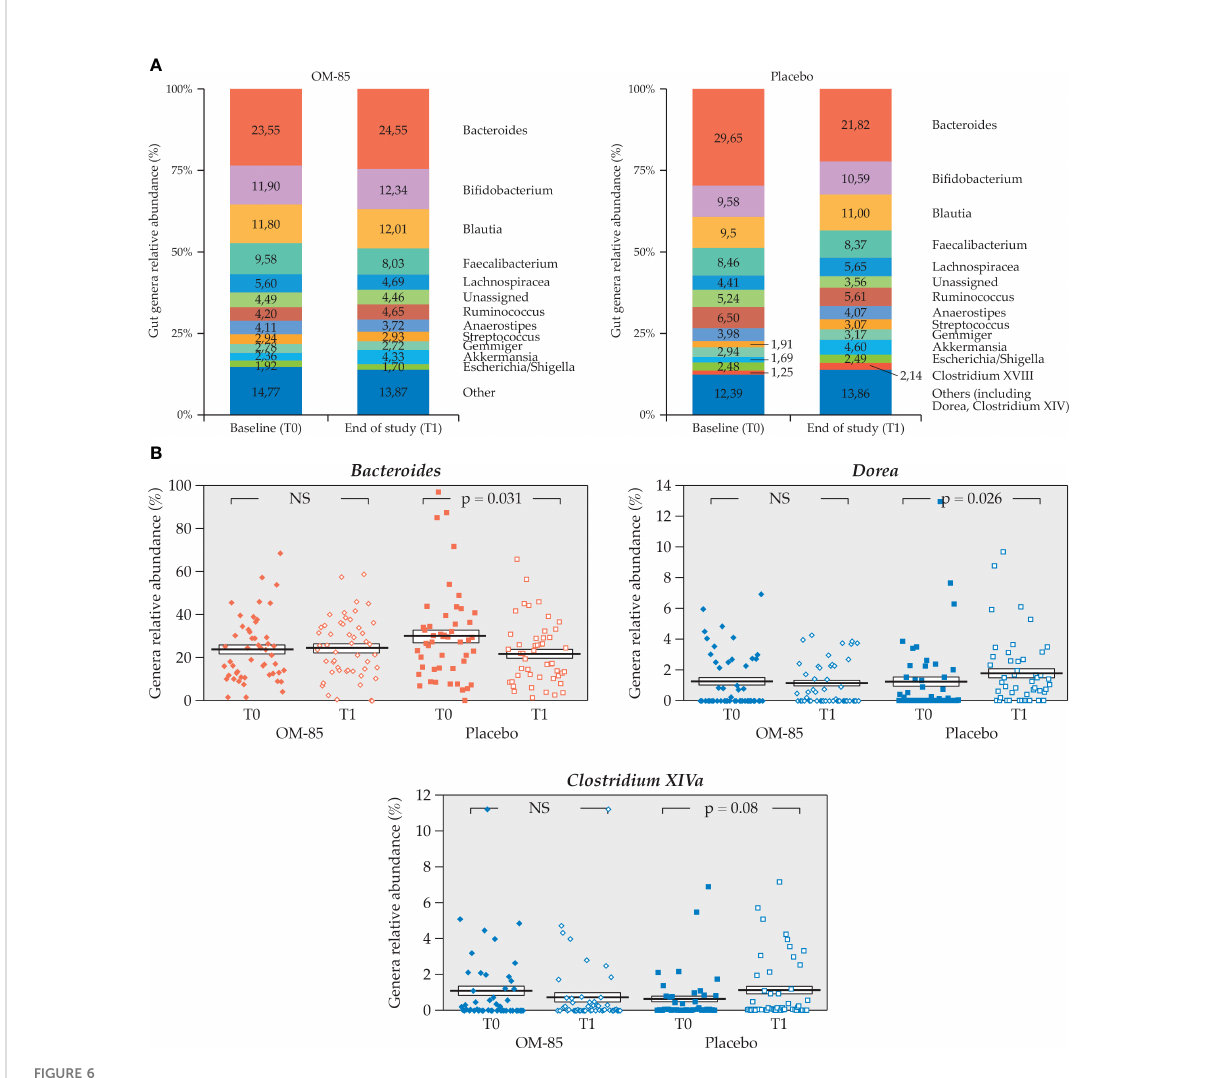
FIGURE 6 Intra – group change of gut microbiota relative abundance in both OM – 85 and placebo groups (n=98). (A) Gut microbiota pro fi les at T0 and T1 for both treatment groups (n=50, OM-85 and n=48, placebo). (B) Statistically signi fi cant intra – group differences for genera Bacteroides, Dorea , and Clostridium XIVa in placebo (Wilcoxon ’ s signed – rank test). NS: not signi fi